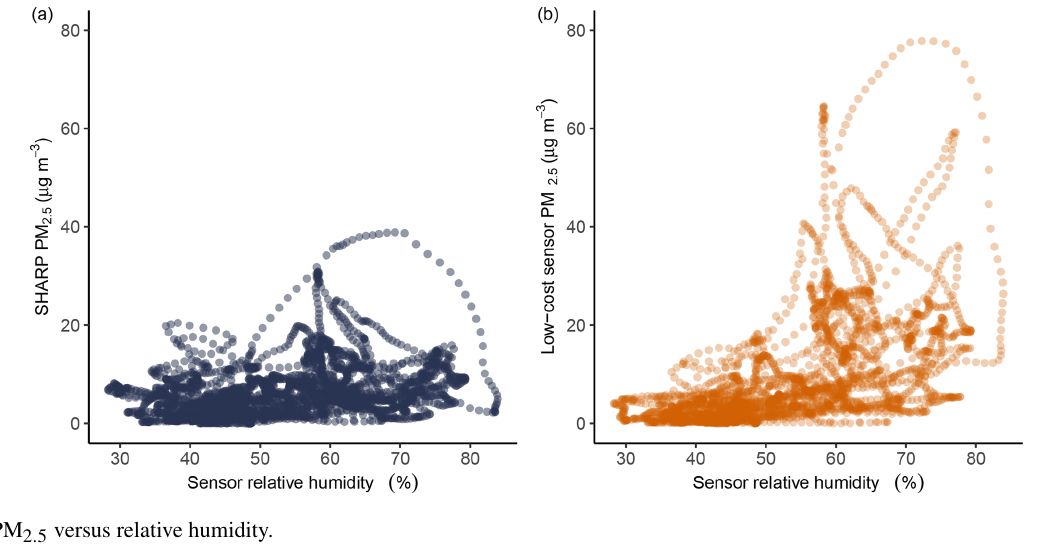
Figure 7. PM 2 . 5 versus relative humidity.